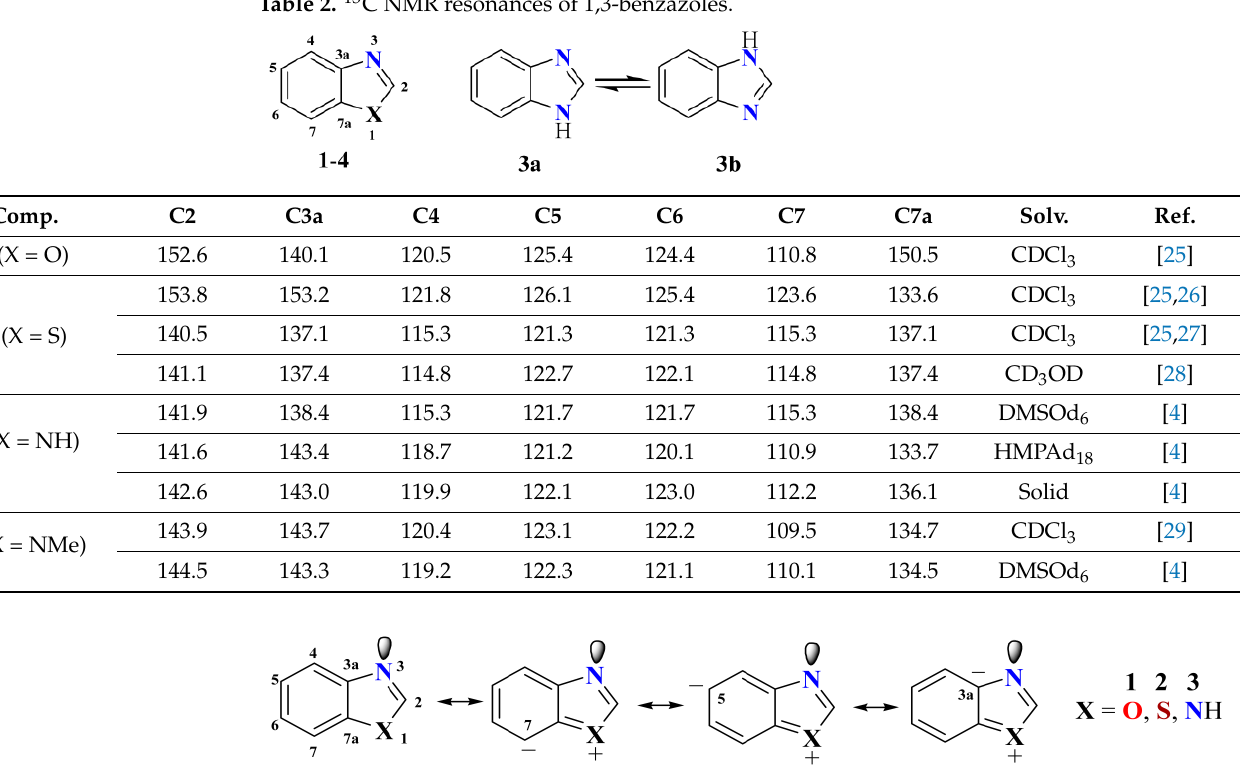
Table 2. 13 C NMR resonances of 1,3-benzazoles.